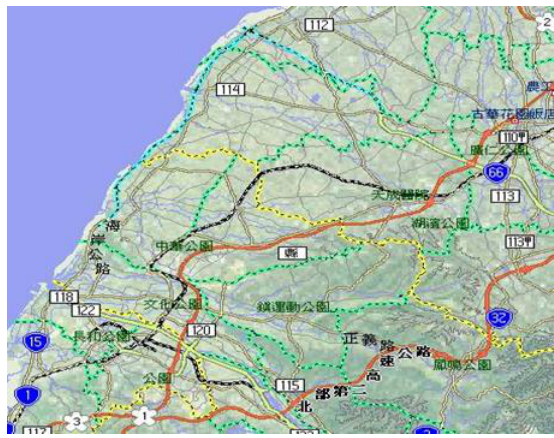
Figure 3. Locations of research areas.